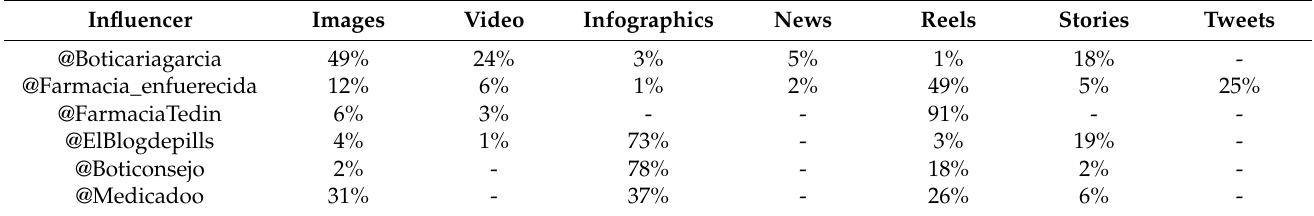
Table 3. Comparison of content dissemination formats used by the different influencer